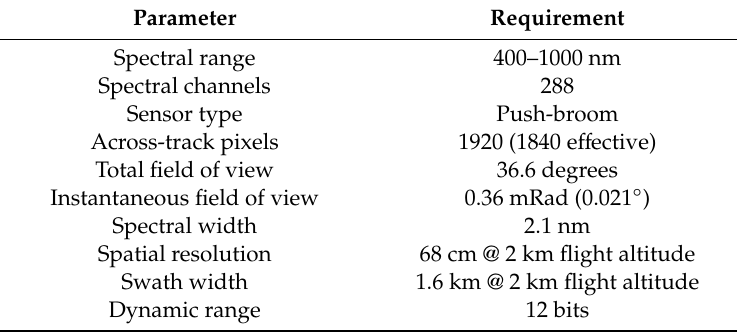
Table 2. Characteristics of the microCASI-1920